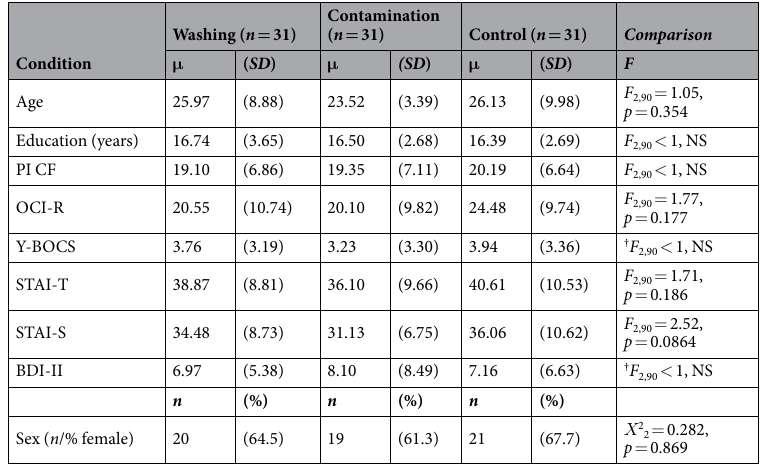
Table 1. Demographic and clinical characteristics for the final randomized groups ( μ , mean; SD , standard deviation; n , sample size; F , F statistic; Χ 2 , chi-square statistic; df , degrees of freedom; p , p value; NS, non- significant; PI CF, Padua Inventory Contamination Fear Subscale; OCI-R, Obsessive–Compulsive Inventory— Revised; Y-BOCS, Yale–Brown Obsessive–Compulsive Scale; STAI-T, Spielberger Trait Anxiety Inventory; STAI-S, Spielberger State Anxiety Inventory; BDI-II, Beck Depression Inventory–II). † After applying a log 10 ( x + 1) transformation, as for the main analysis (see